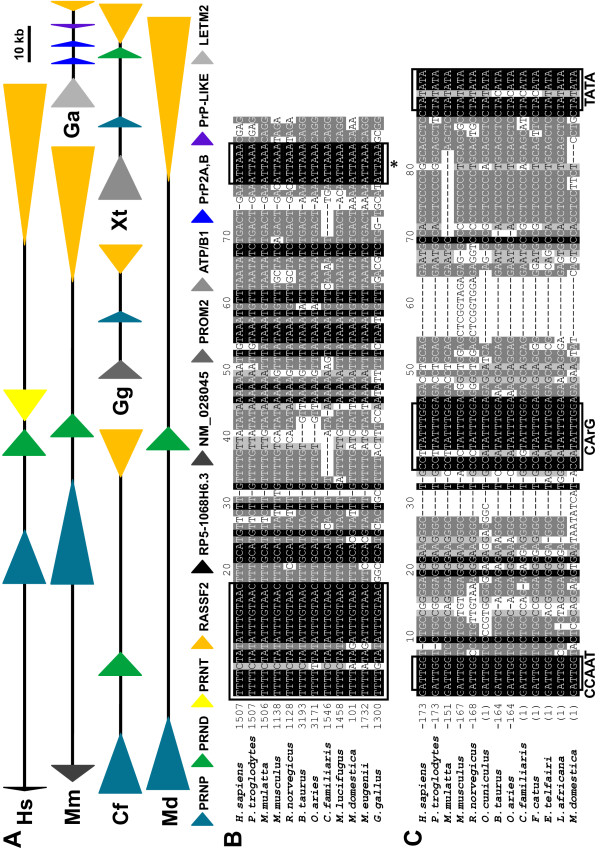
Comparative genomic analysis of PRNP, PRND and PRNT. (A) Gene order and relative gene orientations in the local PRNP genomic contexts located on the human chr. 20 (Hs), mouse chr. 2 (Mm), dog chr. 24 (Cf), opossum chr. 1 (Md), chicken chr. 22 (Gg), western clawed frog scaffold_143 (Xt) and three-spine stickleback chr. 13 (Ga). Detailed genomic sequence coordinates were given in section 4.2. Gene names were explained in the main text. Genes were drawn approximately to scale. The horizontal bar shows 10 kb sequence length. (B) Conserved region in PRNP 3'-UTRs. Sequence coordinates were calculated relative to ORFs. Rectangles denote 17 bp elements, which harbour the potential cytoplasmic polyadenylation element (CPE) sequences (TTTTTAT, consensus CPE sequence in sheep) and highly conserved octamers (TTTGTAAC), as well as nuclear specific-polyadenylation signal sites (ATTAAA) labelled by a star. (C) Conserved region in PRND promoters. Sequence coordinates were calculated relative to introns where possible. Rectangles denote the conserved CCAAT (ATTGG), CArG (CCTTATTTGG) and TATA (TATATA) boxes. (B, C) White letters on black background indicate conservation in 100% sequences, white letters on dark gray background indicate conservation in ≥75% sequences and black letters on light gray background indicate conservation in ≥50% sequences. Cf, Canis familiaris; Ga, Gasterosteus aculeatus; Gg, Gallus gallus; Hs, Homo sapiens; Md, Monodelphis domestica; Mm, Mus musculus; Xt, Xenopus tropicalis.